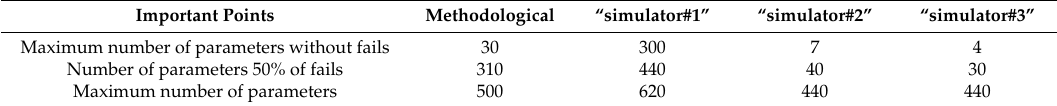
Table 12. Scalability of the proposed co-simulators considering the number of parameters per agent. Important Points